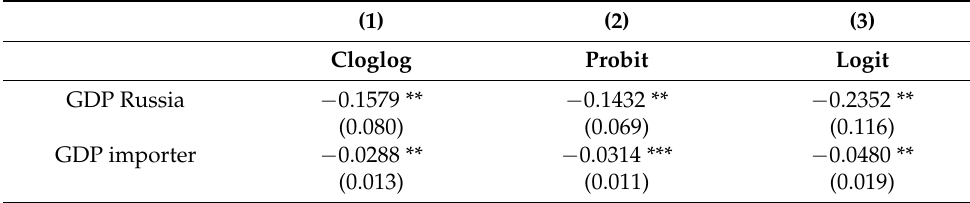
Table 1. Regressions results for duration analysis with random